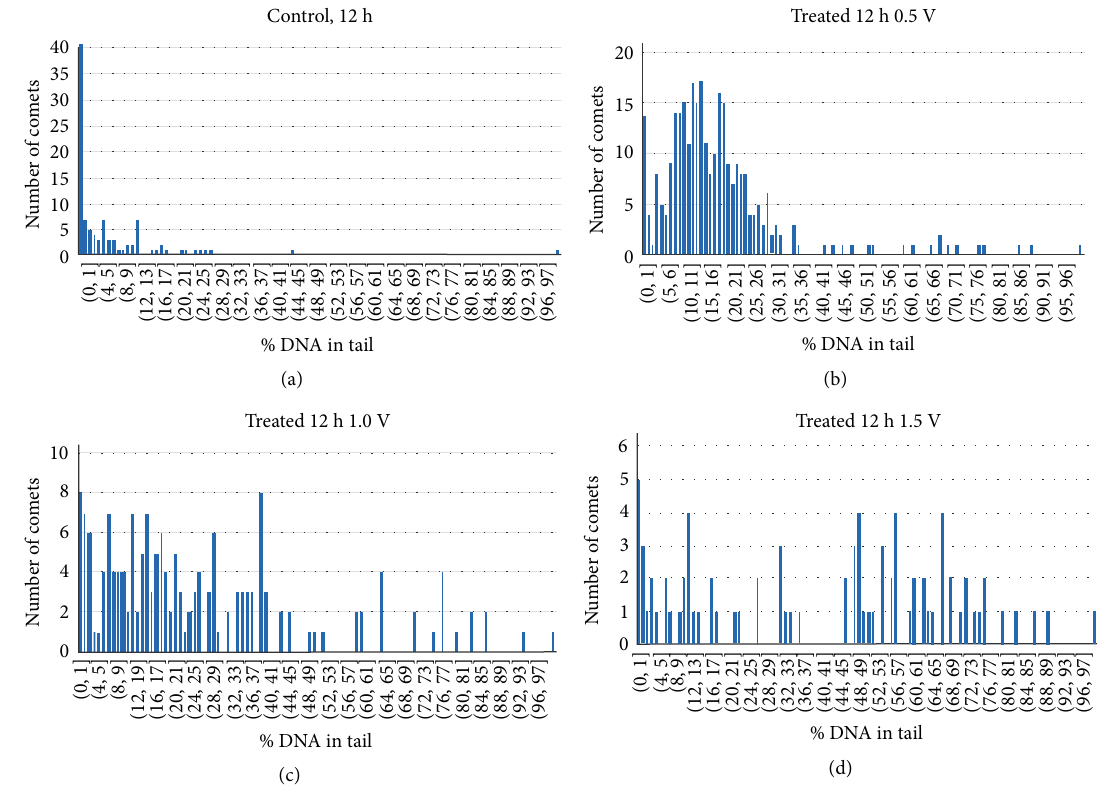
Figure 4: Representative histograms of the distribution of comets (a) control, open circuit for 12 h, 푛 = 103 comets (b) treated for 12 h at 퐸 = 0.5 V, 푛 = 302 comets (c) treated for 12 h at 퐸 = 1.0 V, 푛 = 167 comets (d) treated for 12 h at 퐸 = 1.5 V, 푛 = 82 comets. The number of comets within each bin is plotted as a function of % DNA in tail.